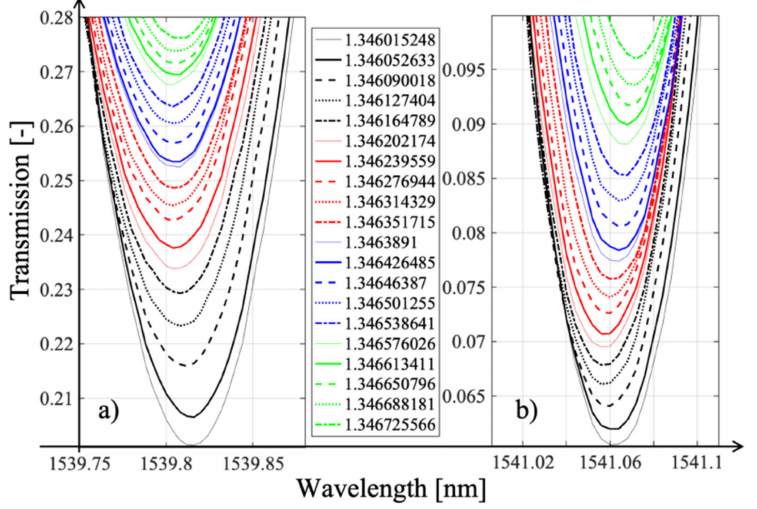
Figure 25. Refractive index measurement results for selected P-TFBG cladding modes: ( a ) @1539.8